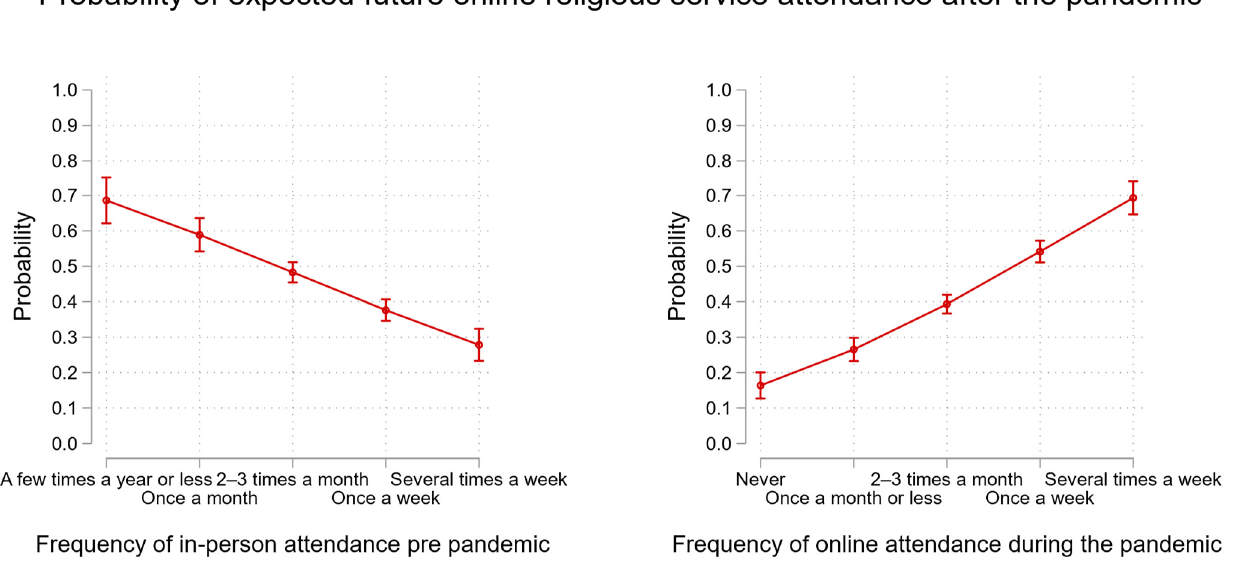
Figure 2. Predicted probabilities of expectations to attend a mix of online and in-person religious services (1) vs. in-person only (0) after the COVID-19 pandemic by the frequencies of in-person service attendance before the pandemic and online service attendance during the pandemic. (n = 1116). Note: The depiction is based on the logistic regression of model 2 and controls for baseline demographic and socioeconomic factors as well as physical health and other aspects of religiosity. The predicted probabilities are calculated when treating the control variables at their mean values. 95% confidence levels of the predictions are shown. Mental Health in Congregations Study, 2020.